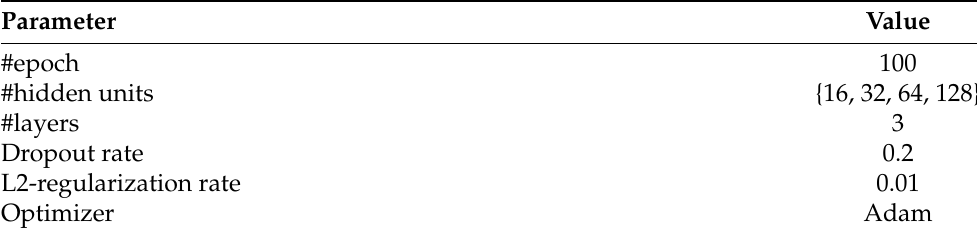
Table 2. Hyperparameters of proposed GCN and GAN